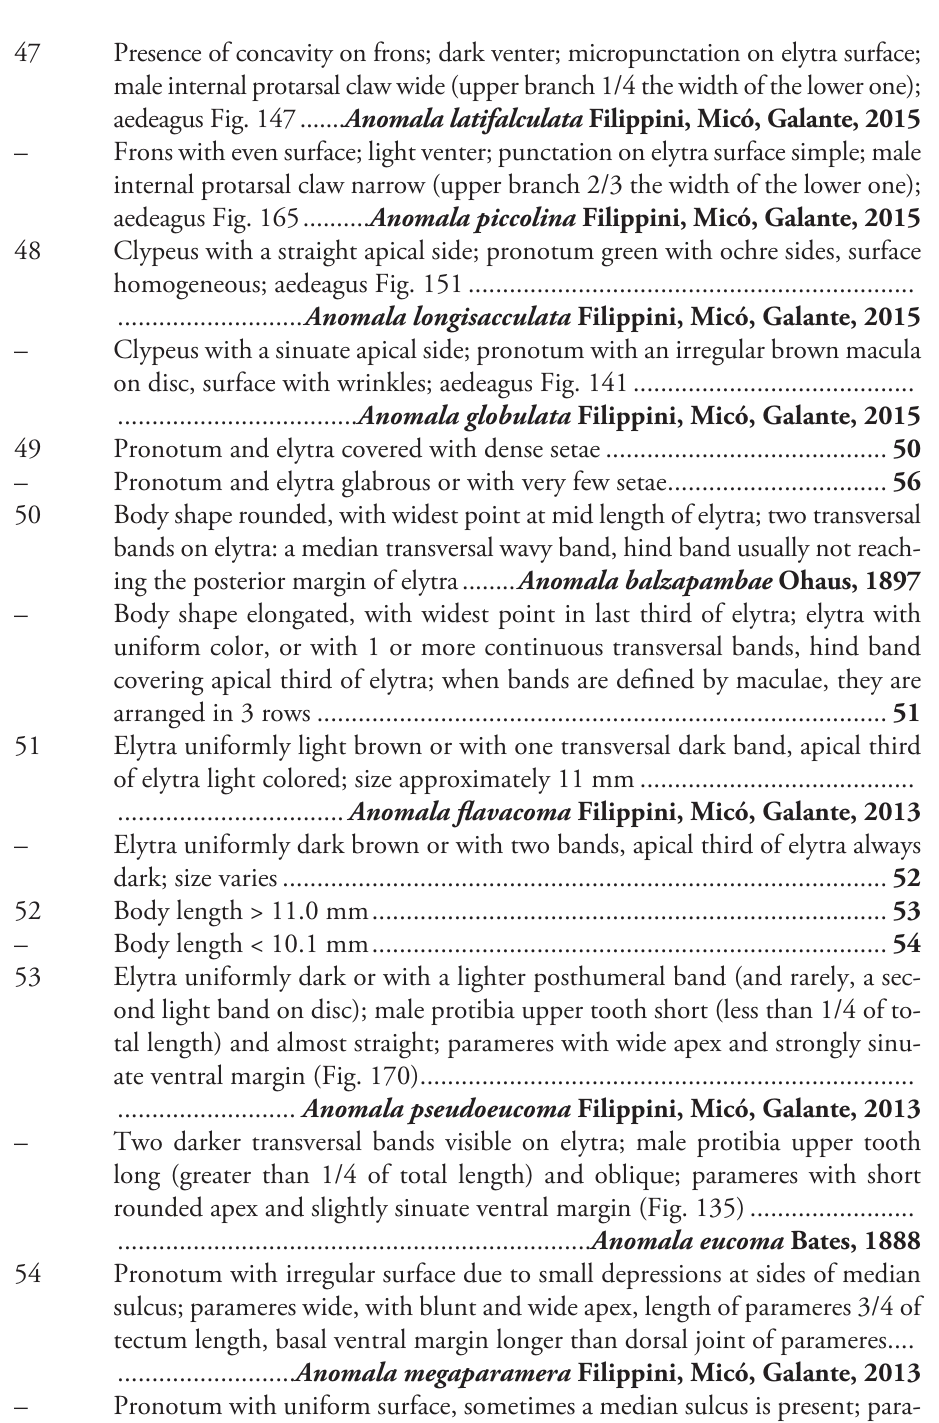
Presence of concavity on frons; dark venter; micropunctation on elytra surface; male internal protarsal claw wide (upper branch 1/4 the width of the lower one); aedeagus Fig. 147 ....... Anomala latifalculata Filippini, Micó, Galante, 2015 – Frons with even surface; light venter; punctation on elytra surface simple; male internal protarsal claw narrow (upper branch 2/3 the width of the lower one); 48 Clypeus with a straight apical side; pronotum green with ochre sides, surface